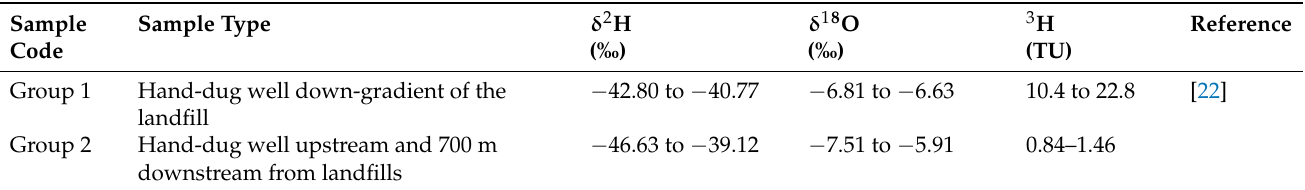
Table 3. Isotope data of hand-dug